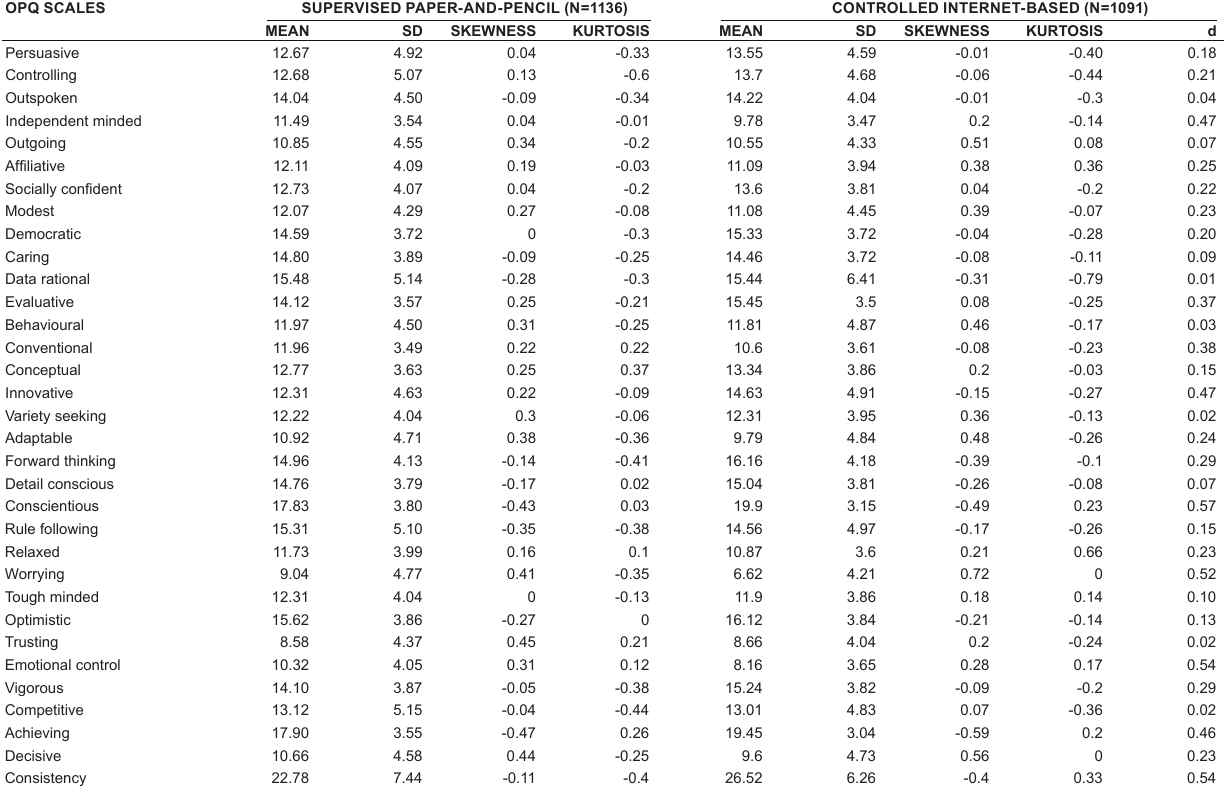
Descriptive statistics and estimated effect sizes of differences between means of graduate supervised paper-and-pencil and controlled Internet-based OPq32i results (study 1) OPQ